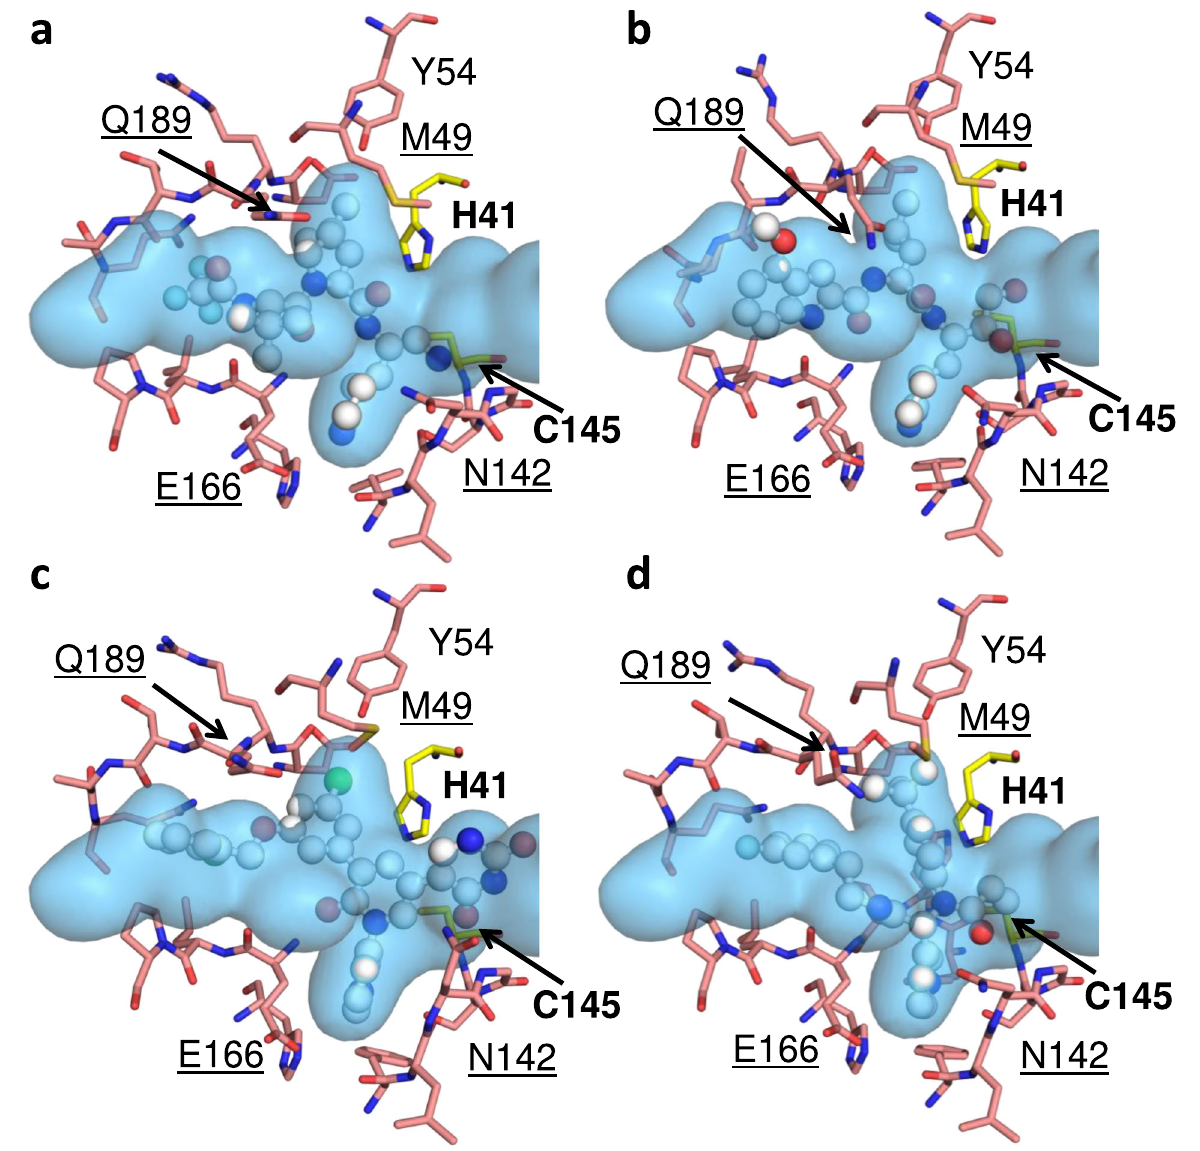
Fig. 5 The fi t of protease inhibitors within the substrate envelope. a PF-07321332 (35), PDB ID:7RFS, b PF-00835231 (36), PDB ID 6XHM. c Noncovalent potent compound 21 (37), PDB ID: 7L13. d Moonshot compound 11 (38), PDB ID 7NW2. The inhibitors are in ball-and-stick representation and the substrate envelope is depicted as the blue volume. The catalytic dyad residues are labeled in bold while the underlined labels are for the residues that interact with one or more inhibitor and may be vulnerable to